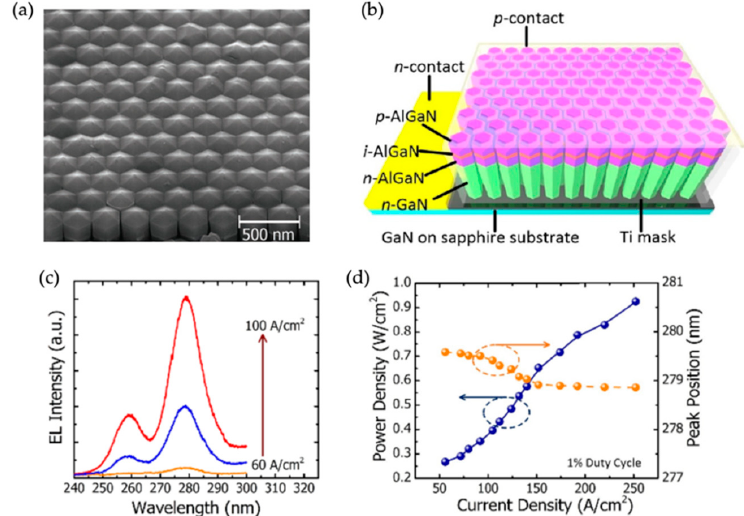
Figure 8. ( a ) SEM image of AlGaN nanowires grown on a patterned GaN-on-sapphire template [61]. ( b ) Schematic of AlGaN nanowire UV LEDs on such a patterned template. [Reprinted/Adapted] with permission from Ref. [60] The Optical Society. ( c,d ) EL spectra and the light output power vs. the injection current density, respectively. Also shown in ( d ) is the peak position vs. the injection current density. Device size: 50 μ m × 50 μ m. [Reprinted/Adapted] with permission from Ref. [60] The Optical Society.